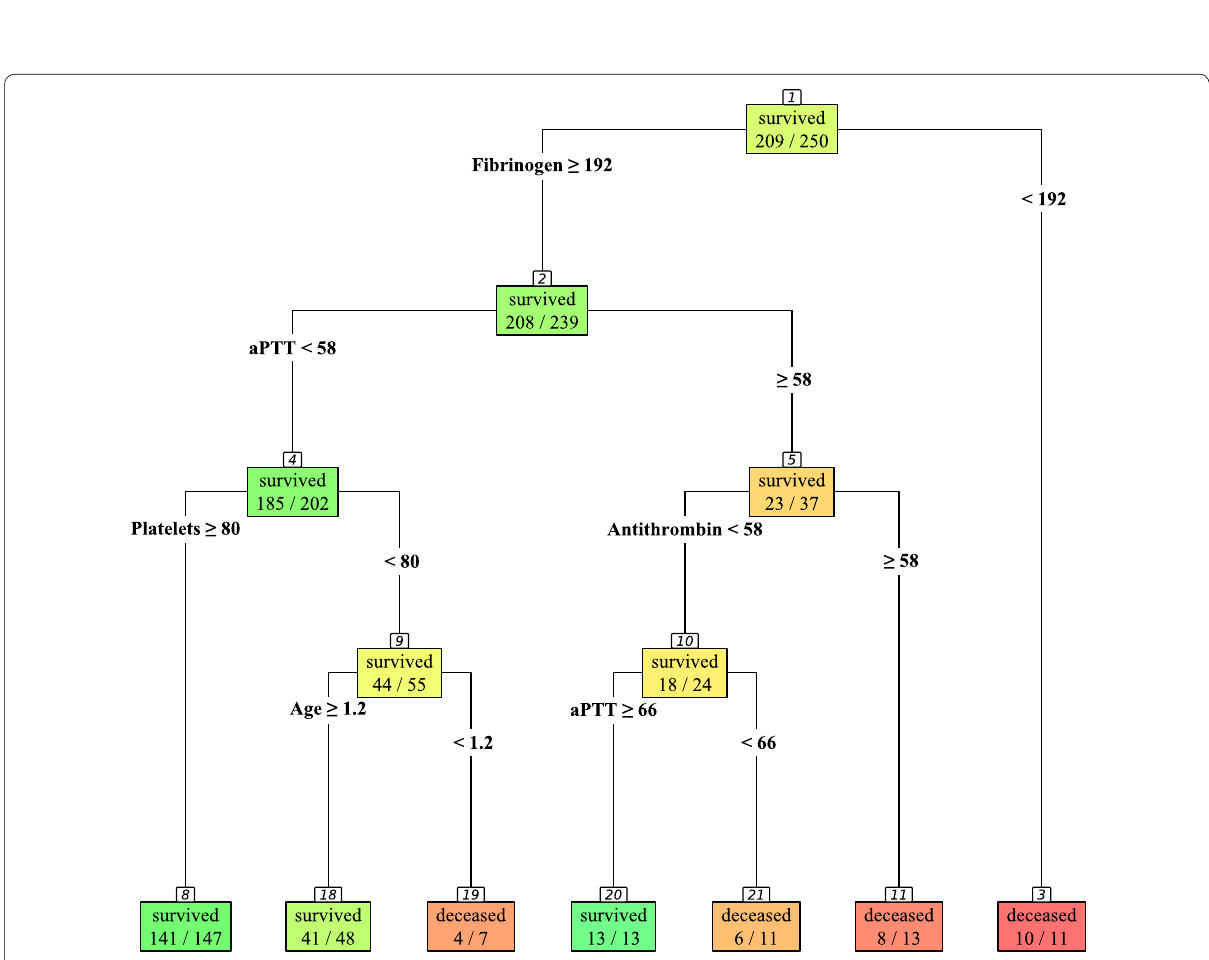
Fig. 4 Decision tree for survival. The classification tree was fitted with univariate predictors at the peak of C-reactive protein and